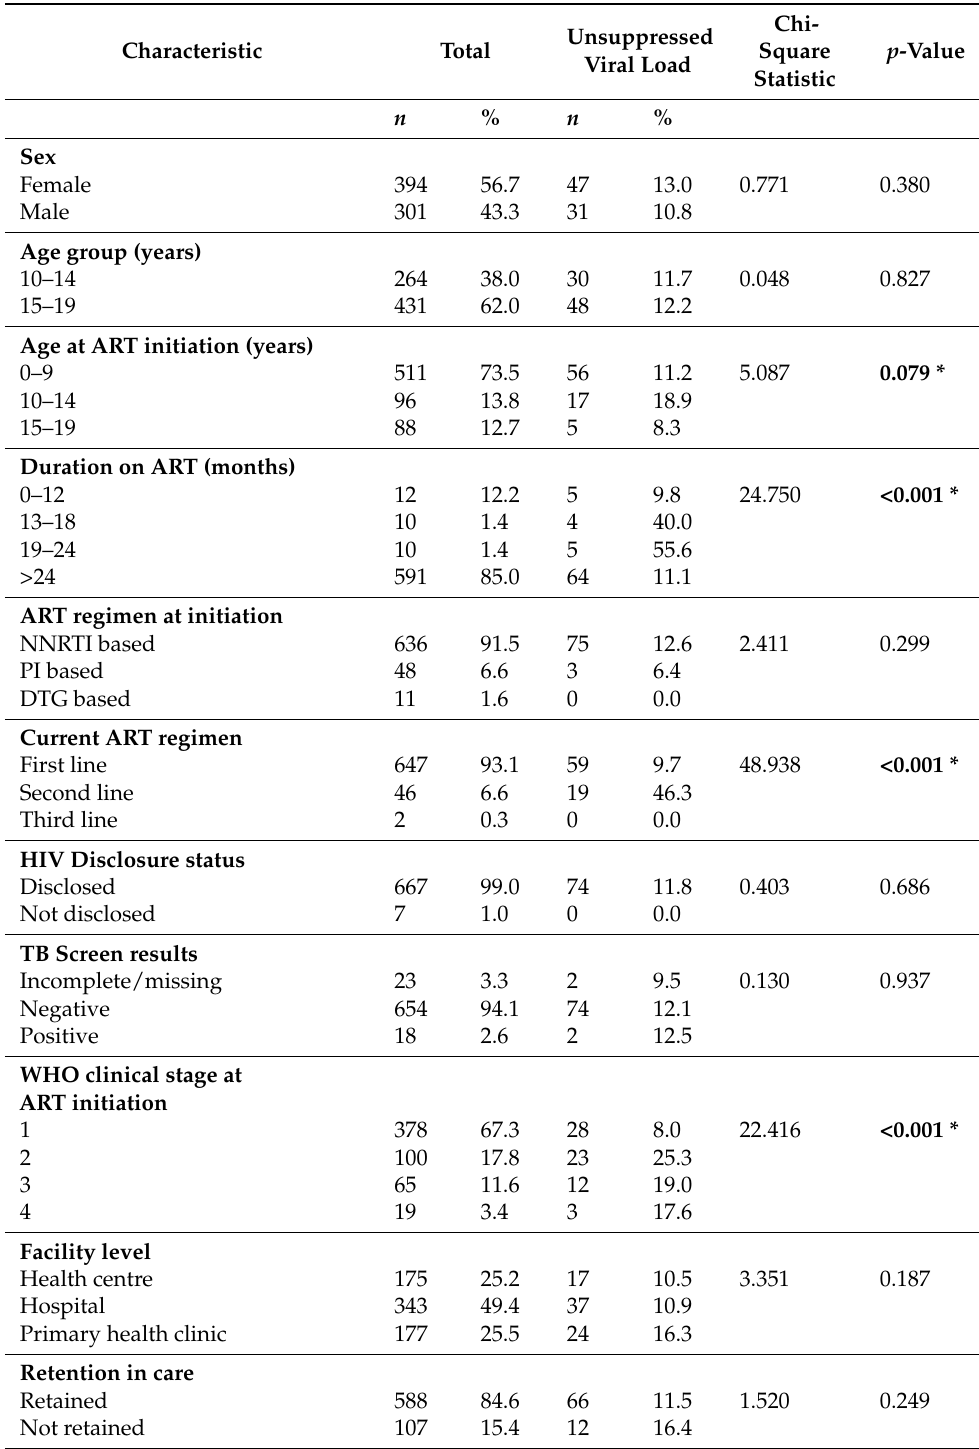
Table 1. Viral non-suppression status by demographic and clinical characteristics of adolescents (10–19 years) on ART in Windhoek District, Namibia: 2019–2021 ( n =